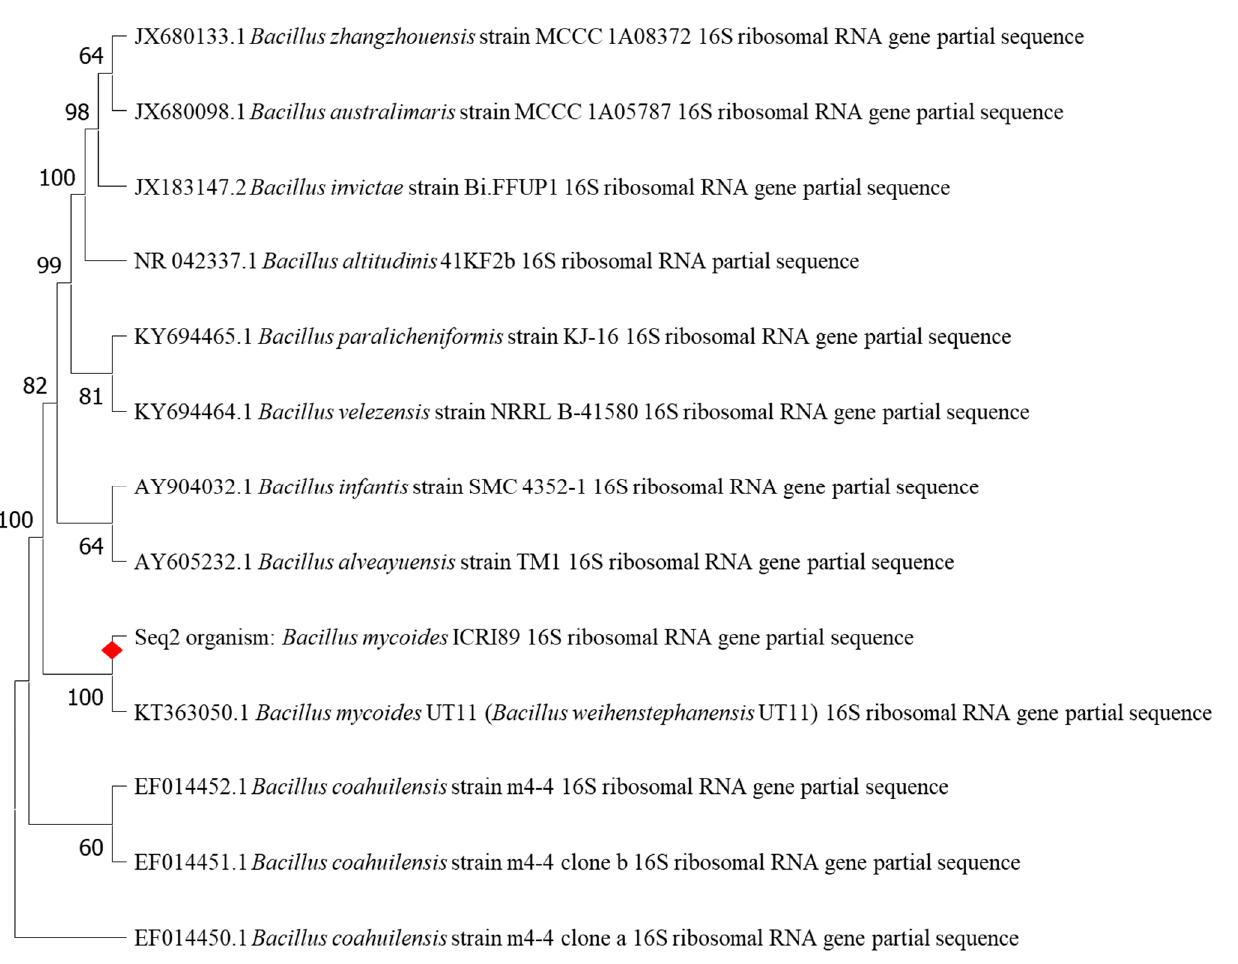
Figure 2. Neighbor-joining phylogenetic analysis based on 16S rRNA gene sequences showing the position of strain B. mycoides ICRI89. These phylogenetic relationships were identified by MEGA 11 sequence alignment editor (version 11.0.11).